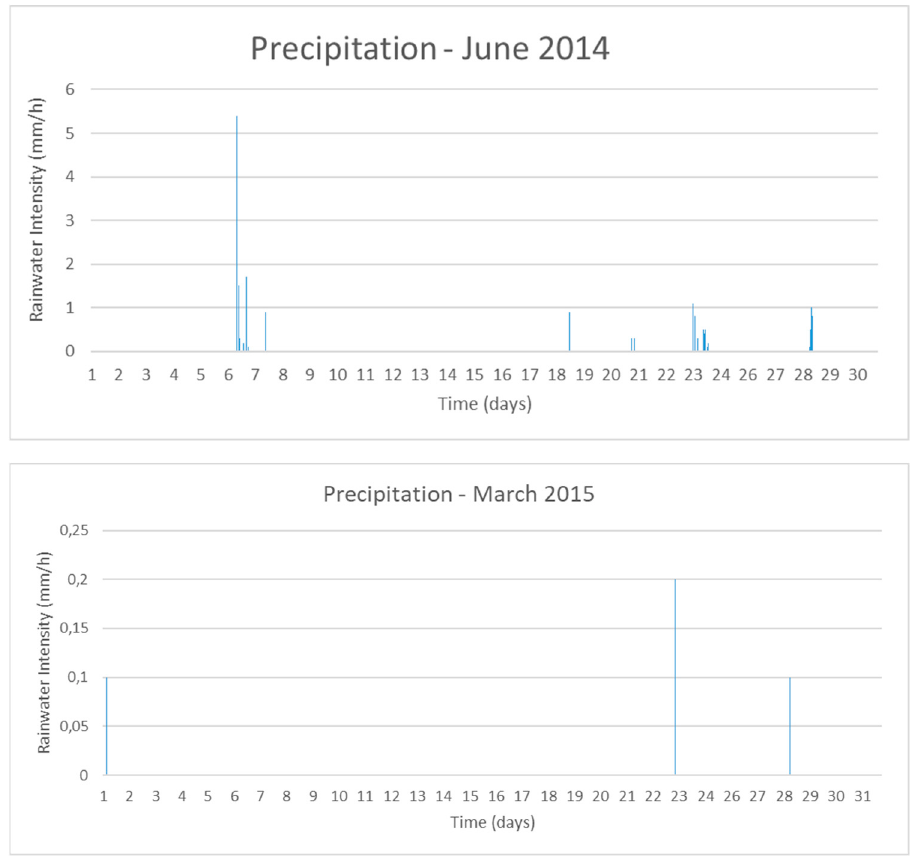
Figure 4. Rainfall records for June 2014 and March 2015.